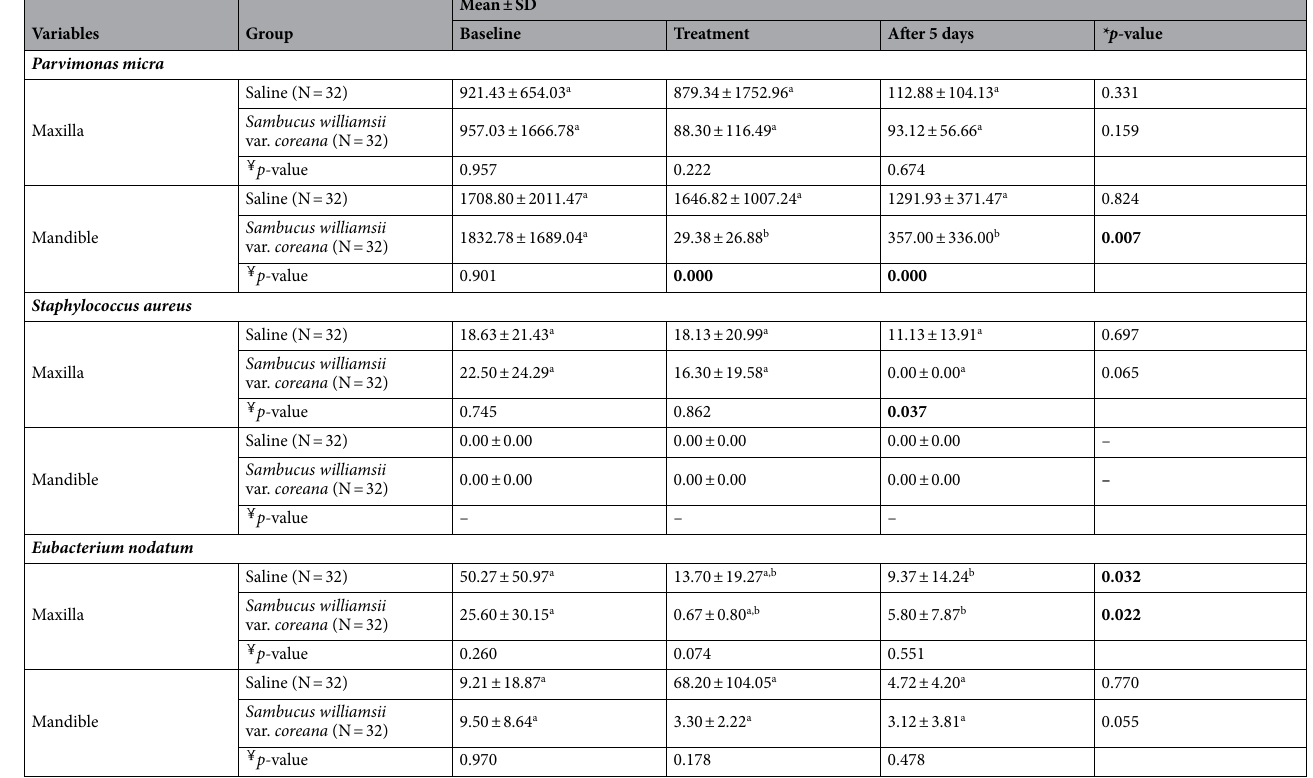
Table 4. Gram-positive bacterial measurements in subgingival plaque (3 types). ￥ p -values are determined by independent t-test, * p -values are determined by one-way ANOVA and different letters (a and b) by the presented statistically significant result of the post hoc Tukey HSD ( P < 0.05). Values are means ± standard deviations. Significant